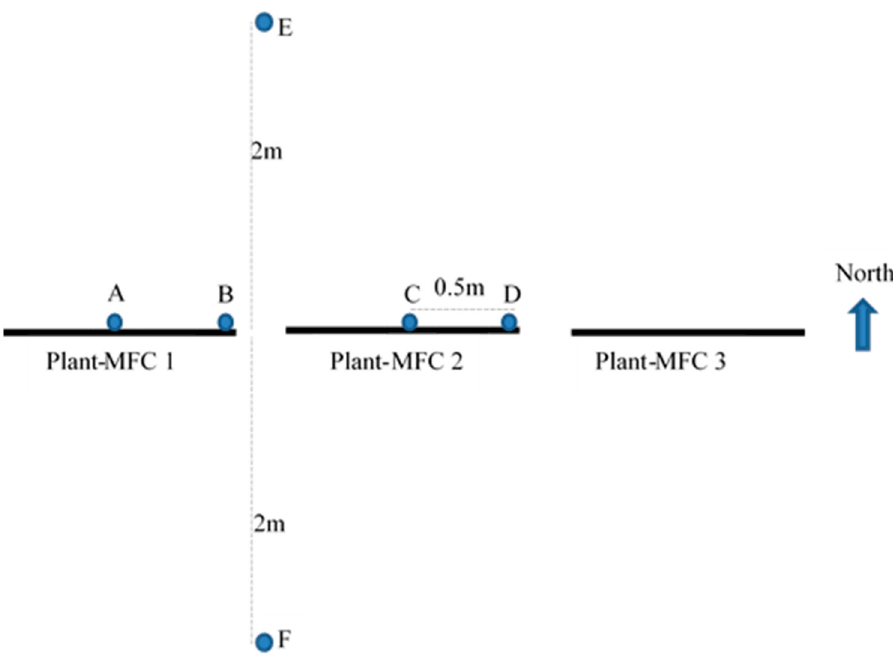
Figure 4. Soil samples collection points.